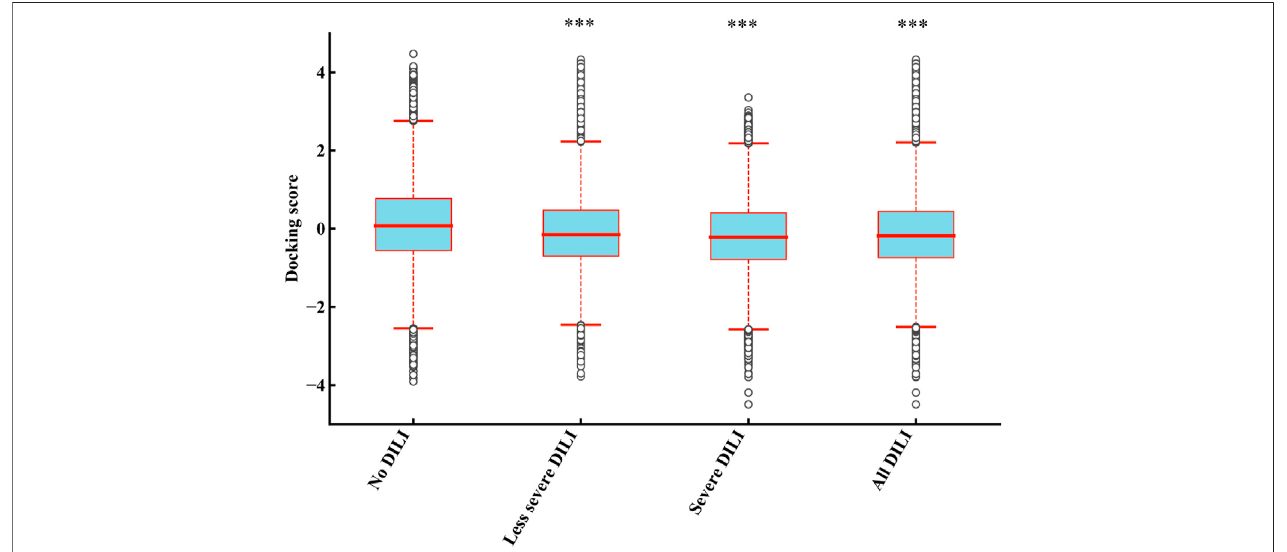
FIGURE3| Comparison ofresultsof187mitochondrialproteinsbindingbetweenDILIgroupsandnoDILIgroup.Thedockingscoresof “ lesssevereDILI, ”“ severe DILI, ” and “ all DILI ” were signi fi cantly lower than those of the “ no DILI ” group (Kruskal – Wallis test). *** p < 0.001.